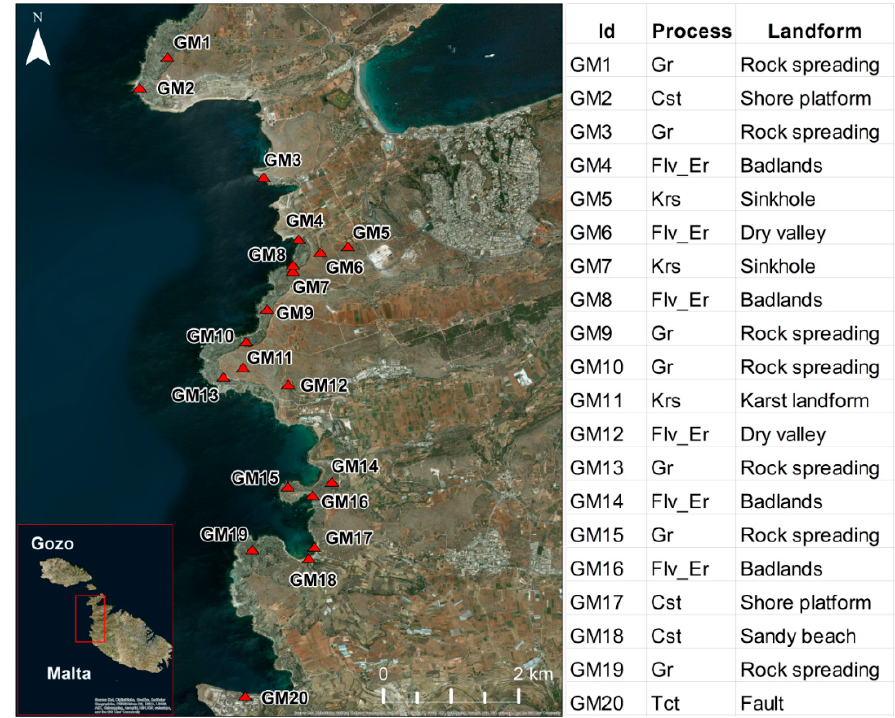
Figure 4. Geosites map of Malta study area (GEOMAL) with the indication of the identification code, the predominant landforms (Gr: gravity-induced landforms, Cst: coastal landforms, Flv_Er: fluvial and water erosion landforms; Krs: karst landforms, Tct: tectonic landforms).